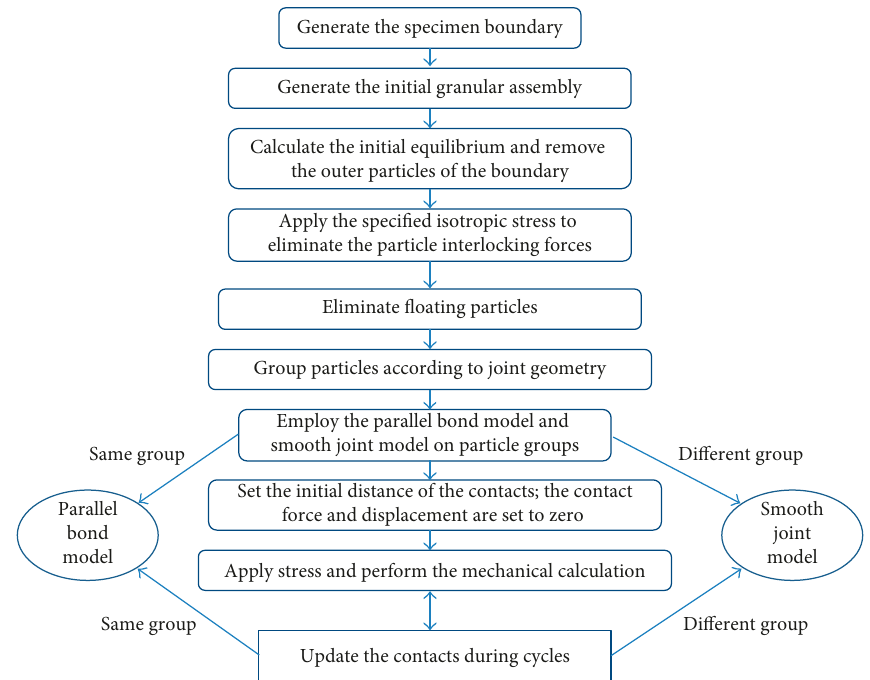
Figure 10: Flow chart for the proposed method of joint generation.